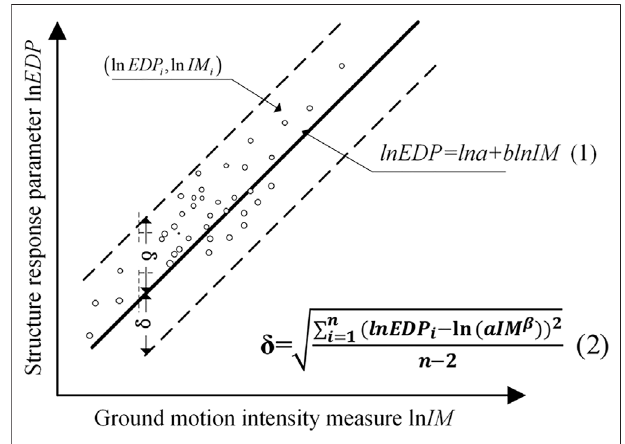
FIGURE 1 | A schematic of the structural seismic demand